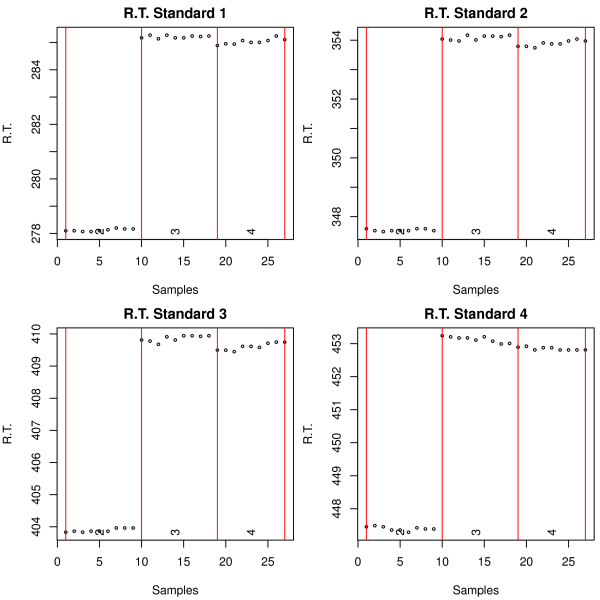
Retention index markers report. Retention time of the first four retention index markers in the standard mixture experiment. Samples and retention times are represented in the x and y-axis, respectively. Different days of measurement are indicated by numbers 2, 3 and 4. A so-called day effect is observed between days 2, and 3 and 4, manifested as a retention time shift.